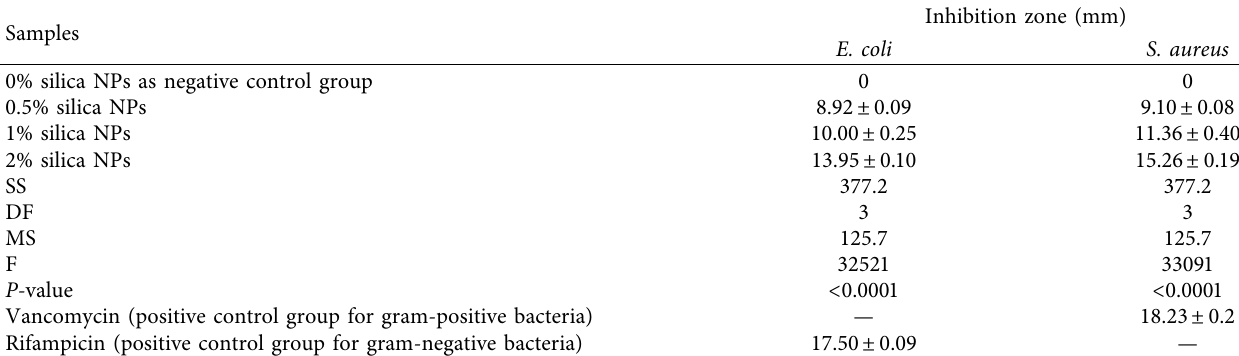
Table 1: Inhibition zone measurements for the groups (0%, 0.5%, 1%, and 2%) and the positive controls against S. aureus and E. coli . Samples